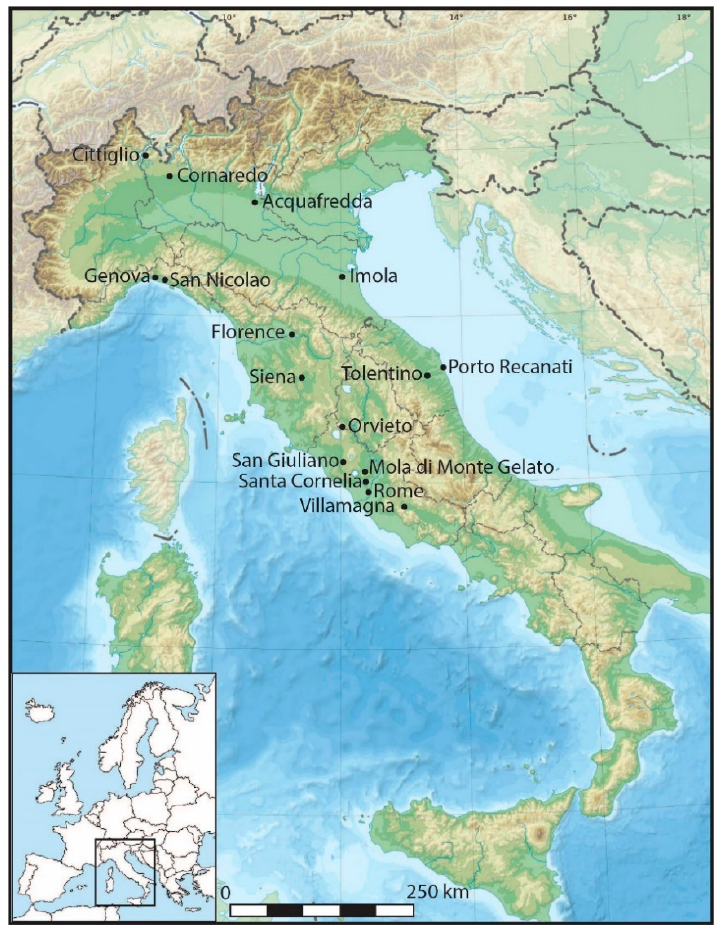
Figure 1. Locations mentioned in the text.